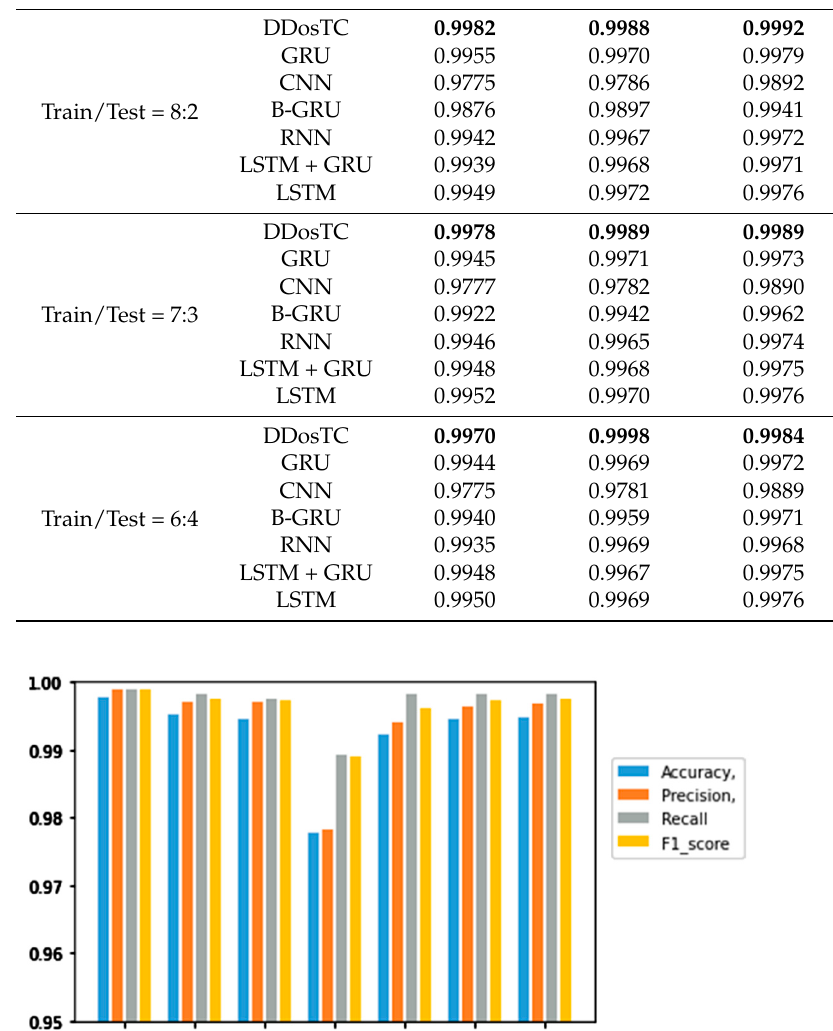
Figure 11. Accuracy, precision, recall rate, and F1 score results for DDosTC and other test methods with a training set/test set ratio of 6:4.